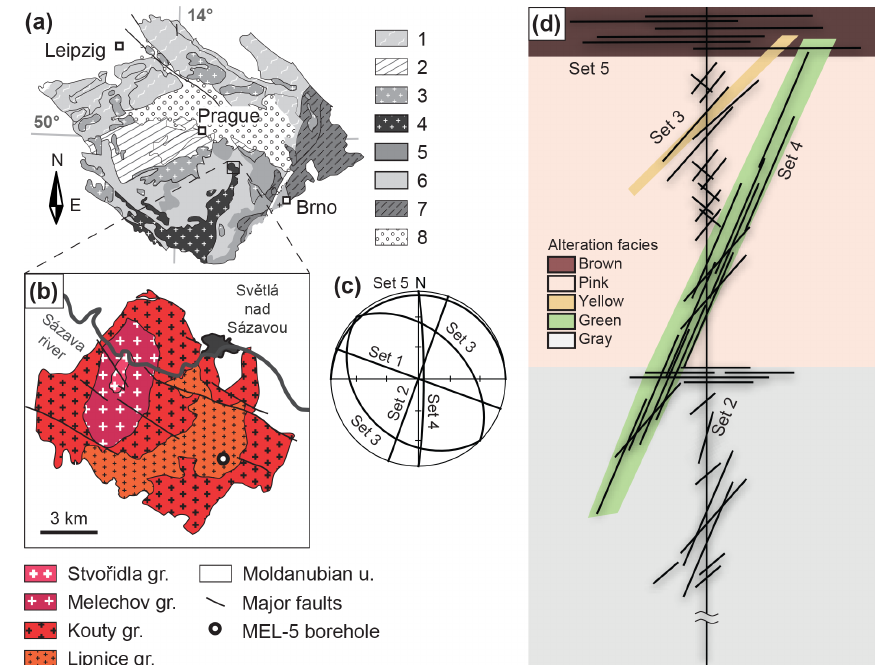
Figure 1. Maps showing the location of the sampled borehole. (a) Simplified geological map of the Bohemian Massif (modified after Franke 2000) 1: Saxothuringian and Lugian, 2: Teplá–Barrandian, 3: Variscan granitoids, 4: Moldanubian batholith, 5: Gföhl assemblage, 6: Drosendorf and Ostrong assemblage, 7: Brunovistulian, and 8: Cretaceous sedimentary cover; (b) geological map of the Melechov pluton (modified after Machek, 2011) with gr. representing granite and u. representing unit; (c) stereoplot (Schmidt projection) of the fracture sets recognized within the Melechov pluton based on Lexa and Schulmann (2006) and Stanˇek (2013); (d) interpretative schematic sketch of the fracture sets and their structural relationship with respect to the alteration facies distribution within the